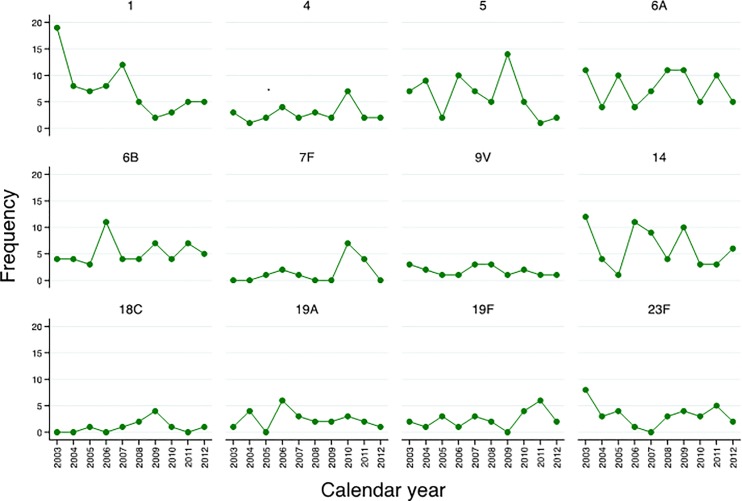
Number of IPD cases caused by most common vaccine types among children <5 years of age admitted at Manhica District Hospital, 2003–2012.